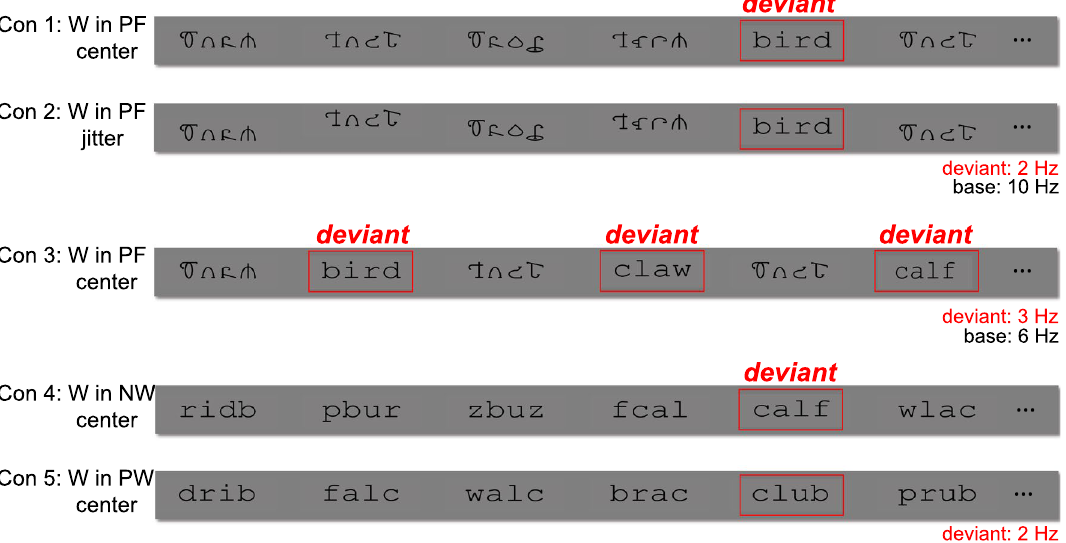
Figure 1. Examples of stimuli presented in the experiment. 2-Hz word deviants were embedded in a stream of pseudofont (W in PF) in conditions 1 and 2 to form a base stimulation rate of 10 Hz. Condition 2 used the same word and pseudofont stimuli as Condition 1, but spatially jittered their location on the monitor. Condition 3 presented the same stimuli used in Condition 1 but with 3-Hz deviant and 6-Hz base frequencies. 2-Hz word deviants were embedded in a stream of nonwords (W in NW) and pseudowords (W in PW) respectively, in conditions 4 and 5, to form a 10-Hz base stimulation frequency.